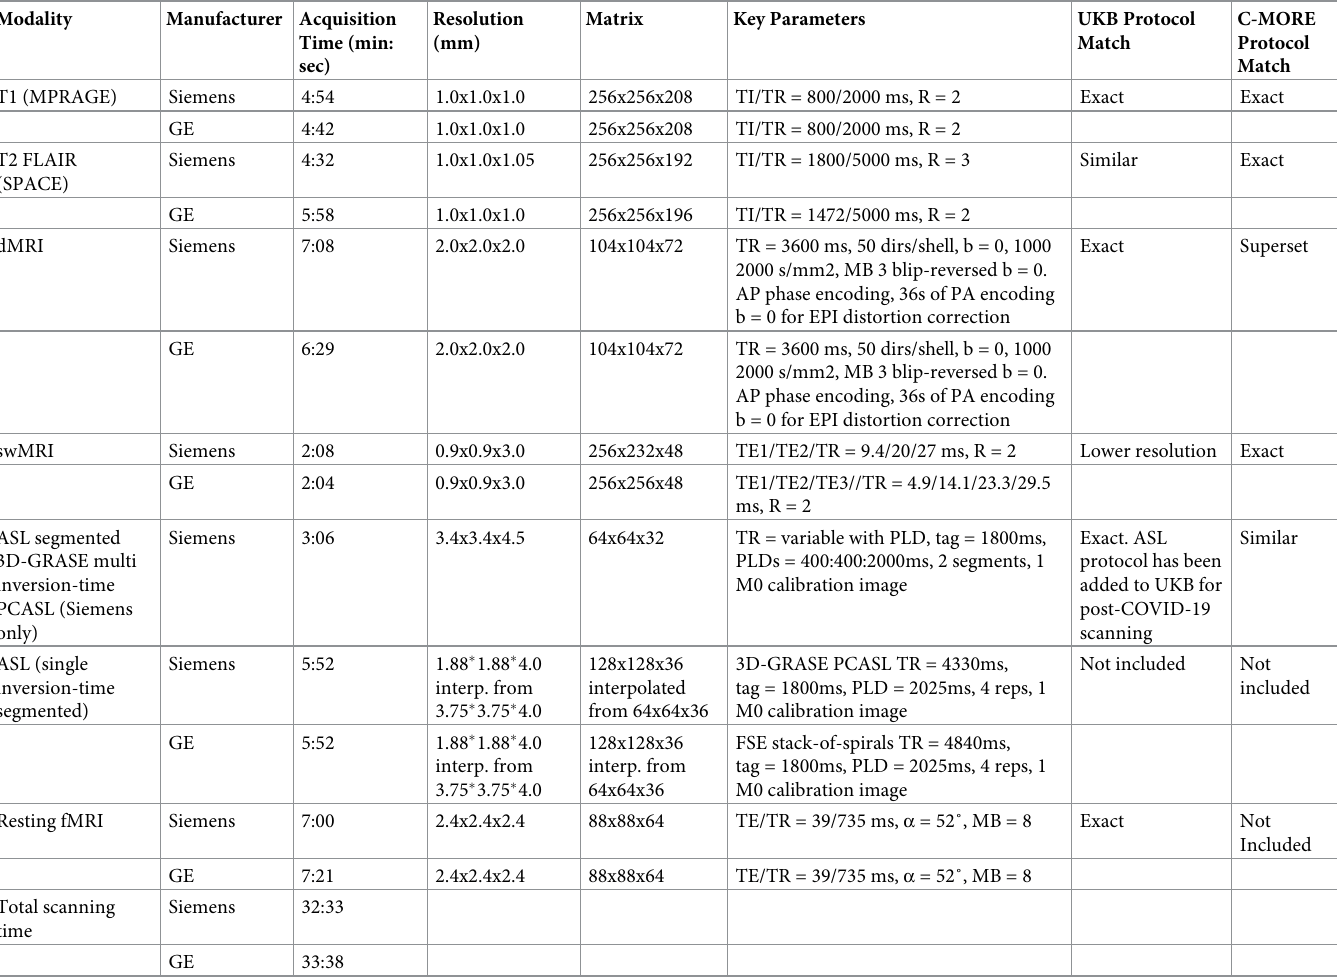
Table 1. Multimodal MRI protocols for COVID-related neuroimaging with Siemens and GE 3T scanners.